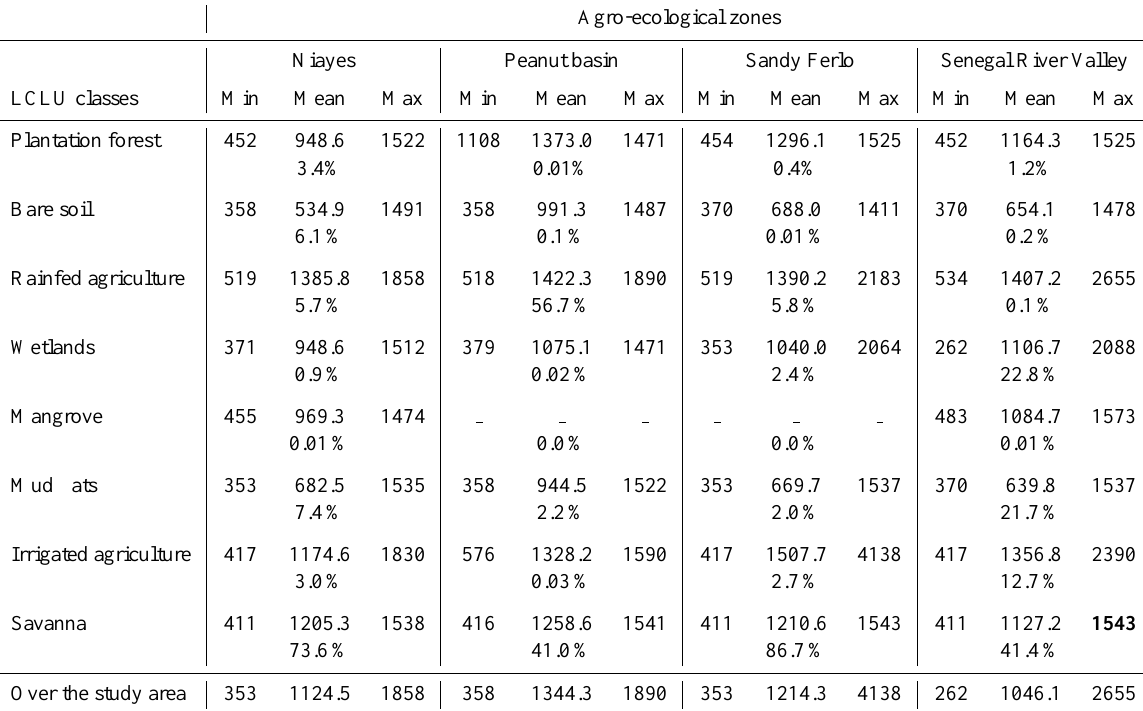
Table 5. Comparison by agro-ecological zone of the minimum, mean and maximum SOC (gCm − 2 ) (Fig. 3) for the 9 LCLU classes using the year 2000 hard classification (Fig. 1). The LCUC percentage area in each zone is shown in parentheses. Only pixels where SOC was modeled are considered (i.e., not water bodies, clouds, cloud shadows, settlement areas, or where there was no Landsat